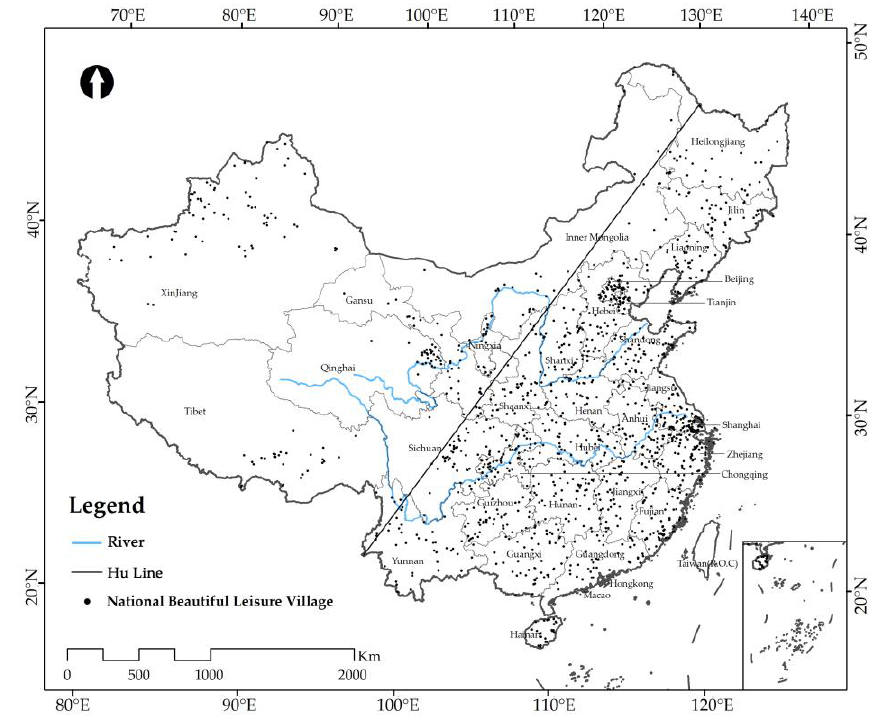
Figure 2. Geographical distribution of beautiful leisure villages in China.